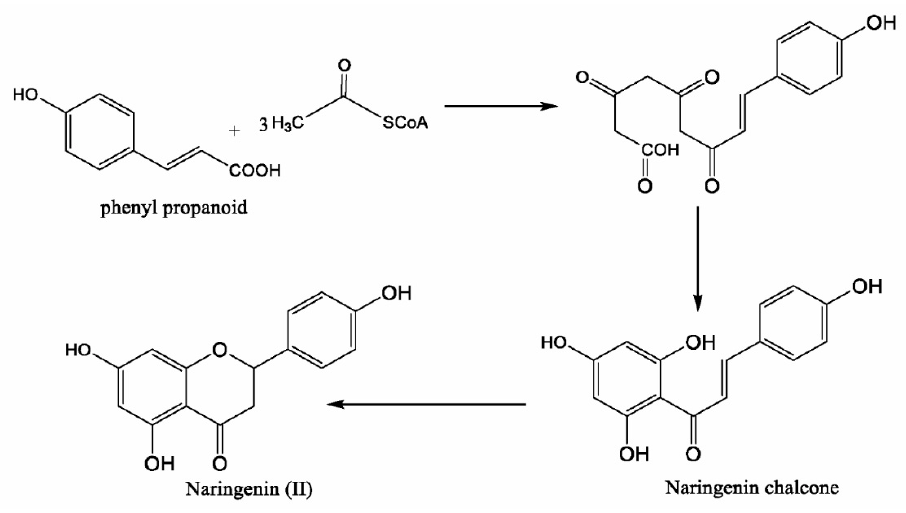
Figure 2. Biosynthesis of naringenin .